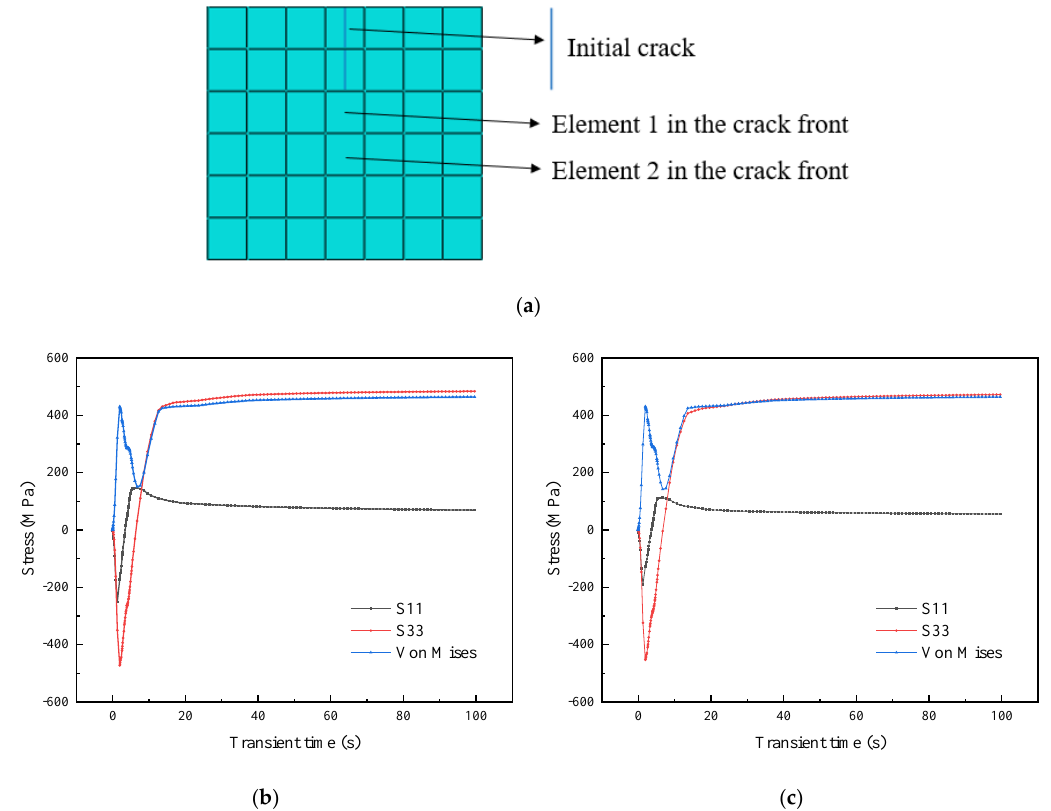
Figure 22. Transient stress curves of the elements in the crack front: ( a ) initial crack and elements in the crack front; ( b ) element 1; ( c ) element 2.